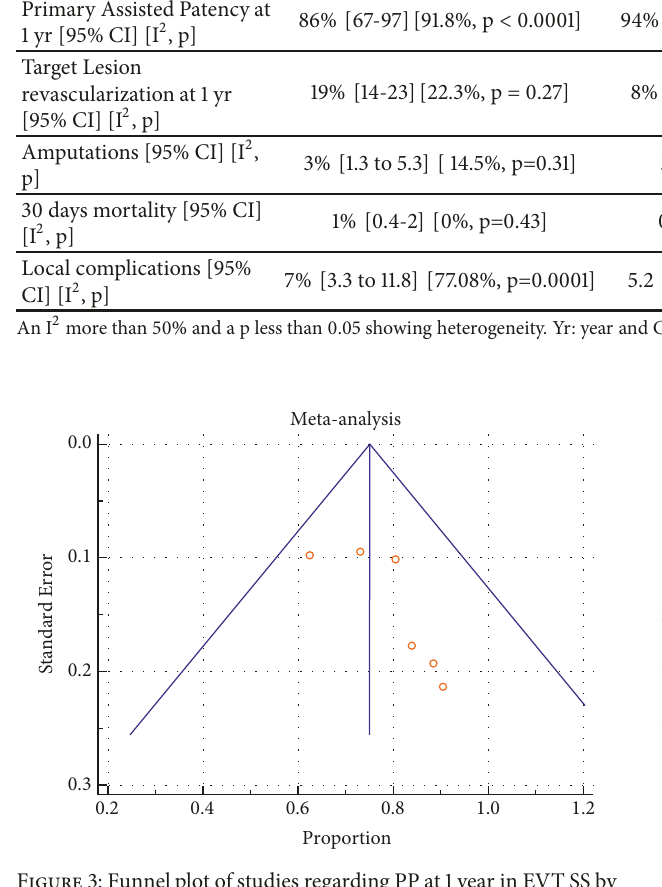
Figure 3: Funnel plot of studies regarding PP at 1 year in EVT SS by Egger test: